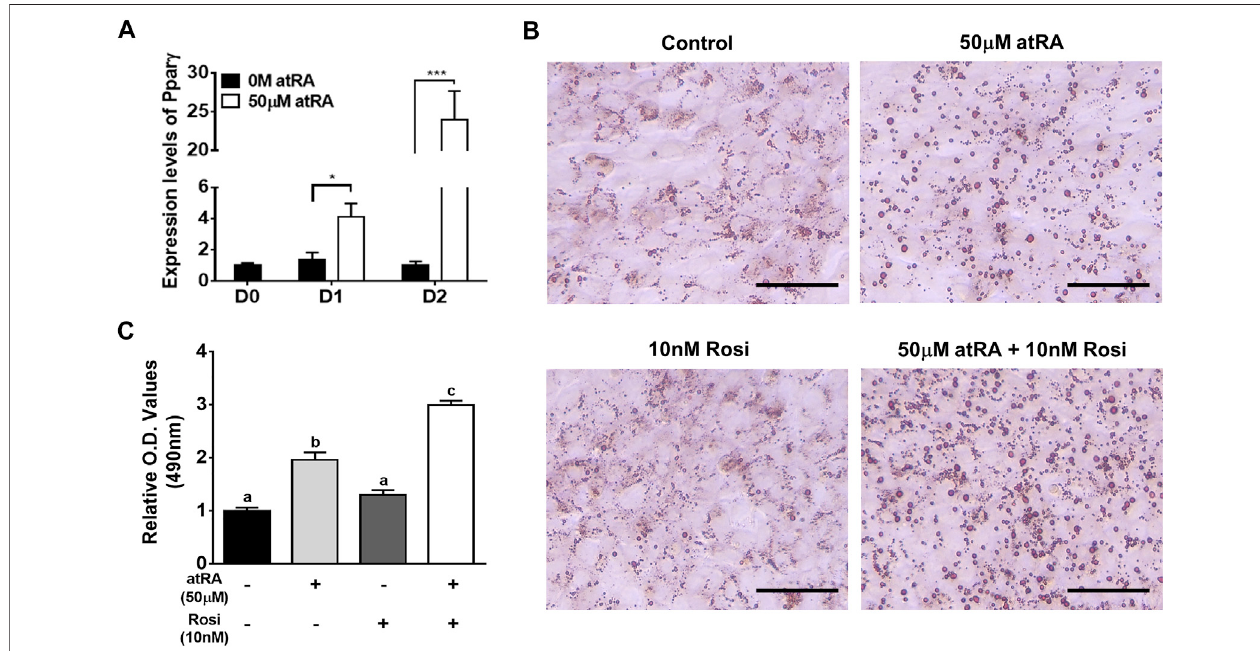
FIGURE7| EffectofRosiasaco-activatoronlipidaccumulation.ExpressionlevelsofPpar γ inQM7cells (A) .ExpressionlevelsofPpar γ weremeasured for2 days after supplementationof50 μ MofatRA in10%CS.Gapdhwasusedasahousekeepinggeneandtheexpression levelsarenormalized bythelevels atday (D) 0. t -tests wereused forstatistical analysisbetweenthetwo groups, the0 M and 50 μ M ofatRA,at D1 orD2, respectively, bythe GraphPad PRISM6.02 program. *: p < 0.05; ***: p < 0.001. Visualization (B) and quanti fi cation (C) of lipid accumulation. QM7 cells were grown in four different media for 2 days: 10% CS as a control media, 10% CS with 50 μ M of atRA (50 μ M), 10% CS with 10 nM of Rosi, and atRA 10% CS with both 50 μ M of atRA and 10 nM of Rosi, both, and then assessed for lipid